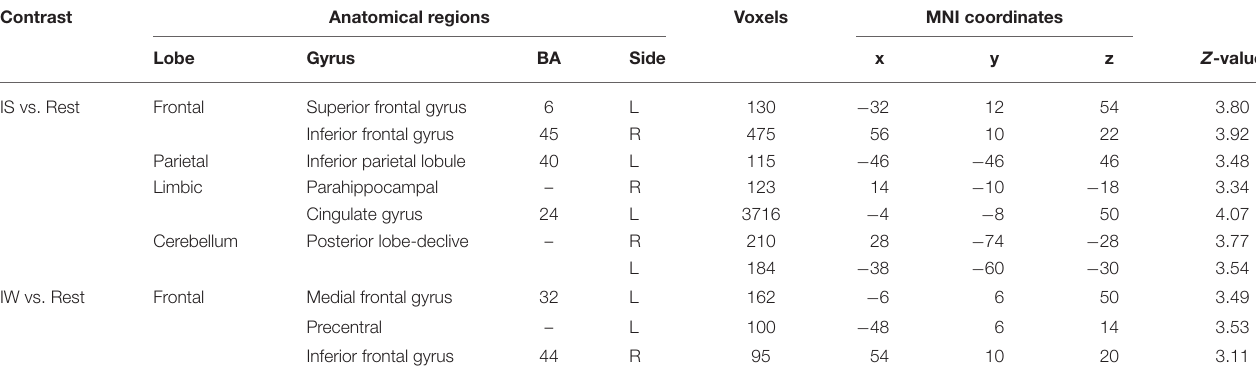
IS, Imagined slipping; IW, Imagined walking; MNI, Montreal Neurological Institute; BA, Broadmann area; SMA, Supplementary motor area. All activations were observed at p < 0.01 and k 80. = TABLE 2 | Differences in pre and post treadmill-slip perturbation training brain activation in imagined slipping and imagined walking conditions. Contrast Anatomical region Voxels MNI coordinates Lobe Gyrus BA Side x y z Z -value IS Frontal Occipital